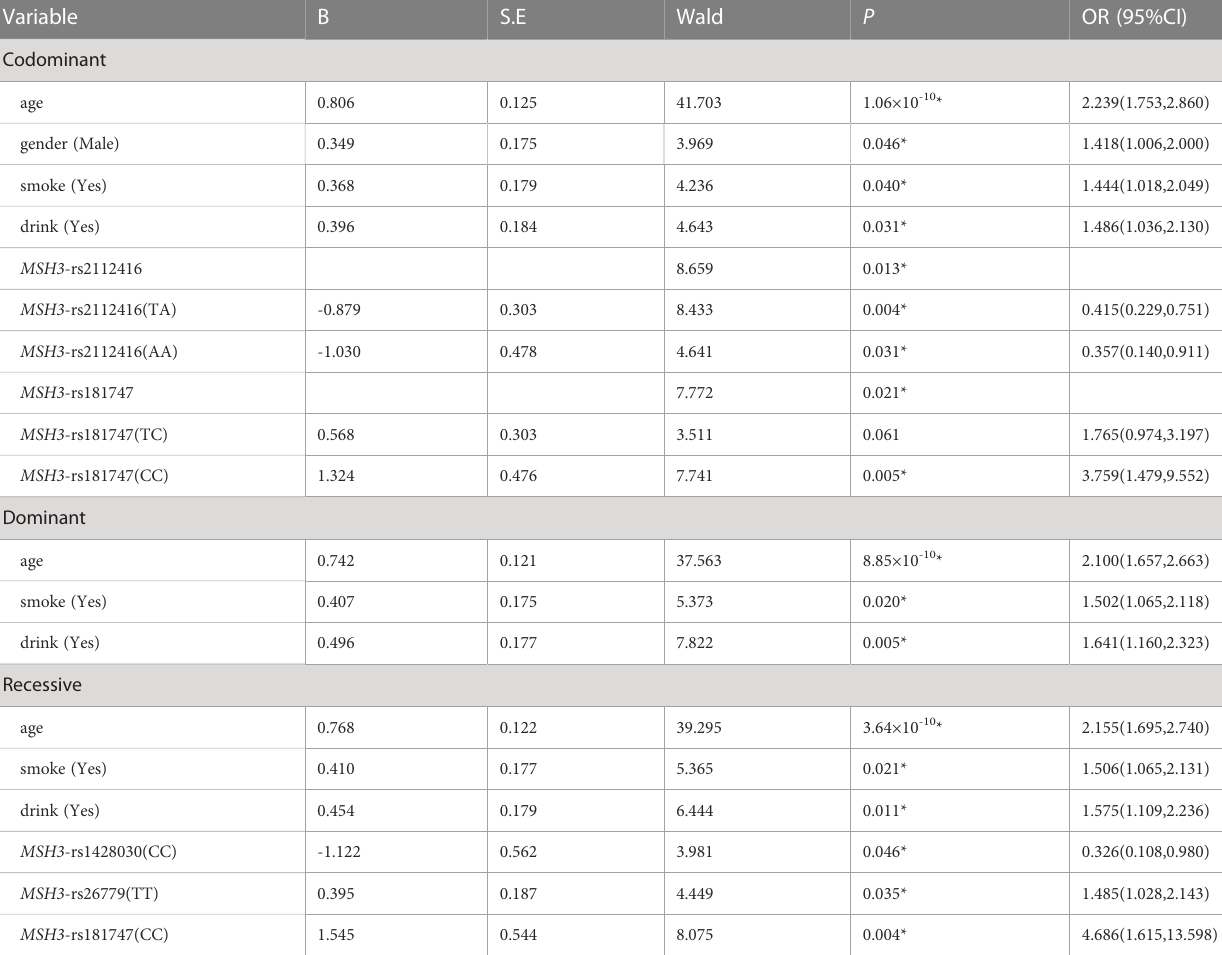
TABLE 8 Multiple logistic regression analysis of predictive factors for hepatocellular carcinoma between LC and HCC in three models.